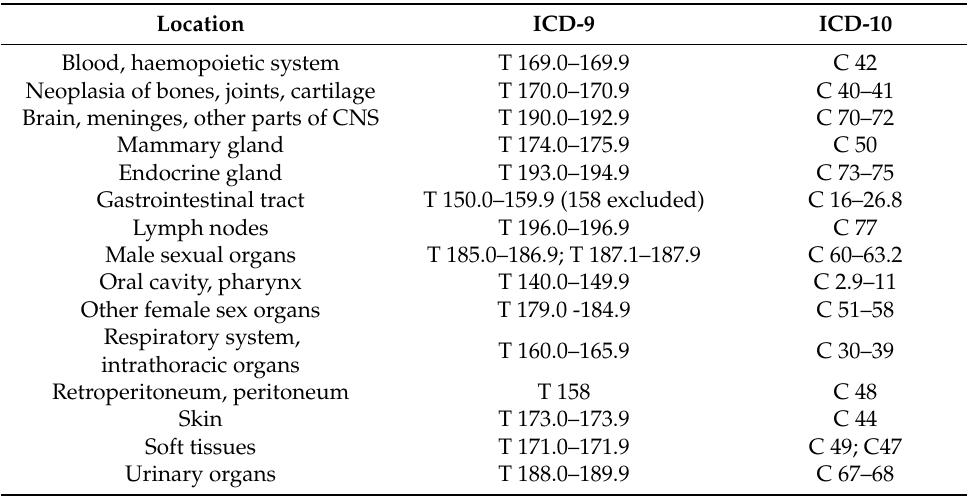
Table A1. Coding of tumour locations according to Grunzig et al.